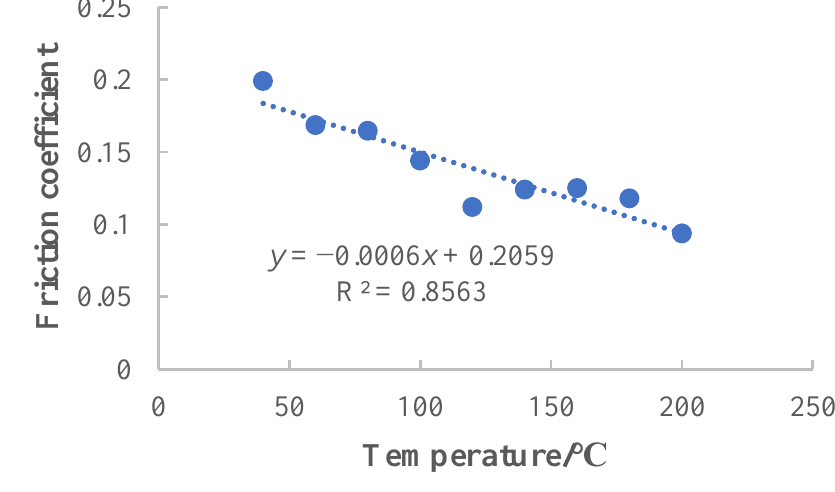
Figure 9. Linear fitted f and T.